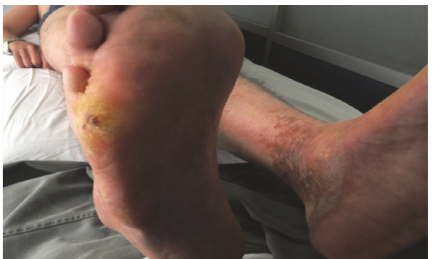
Figure 2: Lower limbs with markedly atrophied skin and subcuta- neous fat, abnormal pigmentation of the skin and hyperkeratosis in theleftperimalleolararea,flatfeet,plantarhyperkeratosis,andcallus in the right 5th metatarsal head and 5th metatarsal base areas.